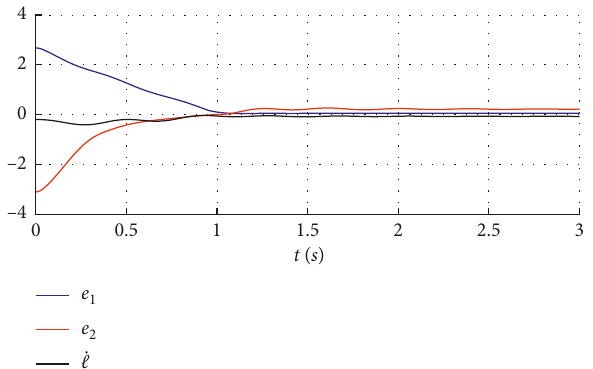
Figure 10: Positioning error response for nonideal loading ma- nipulator with DC motor.